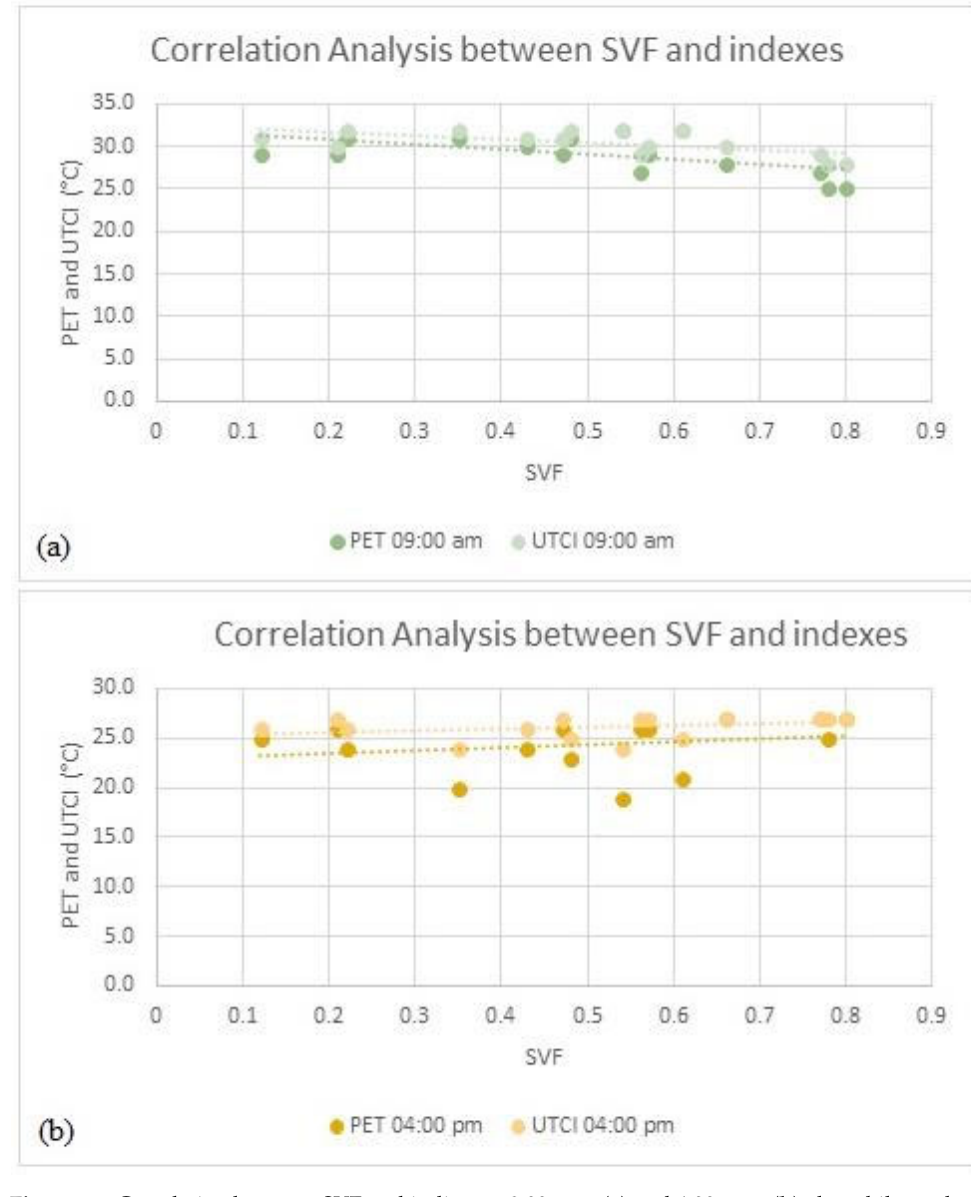
Figure 10. Correlation between SVF and indices at 9:00 a.m. ( a ) and 4:00 p.m. ( b ) along bike paths in Balneário Camboriú/SC. Source: Authors (2022).